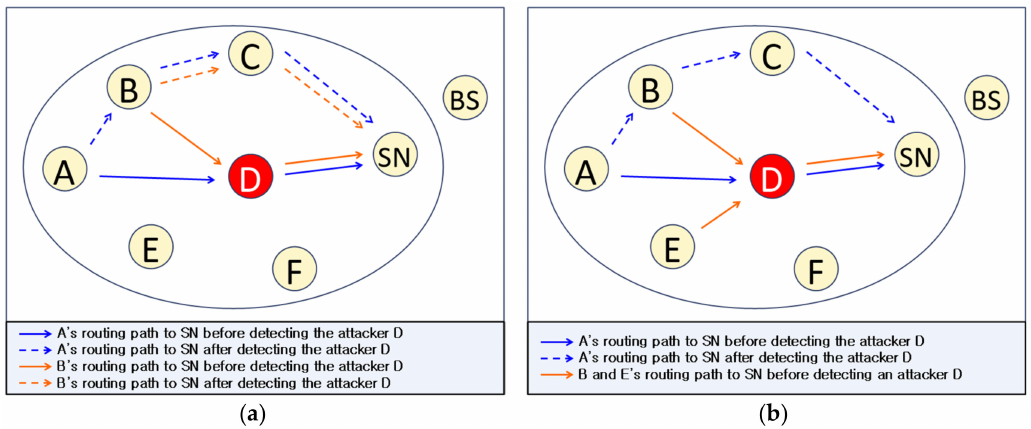
Figure 4. Motivational examples (two attack cases). ( a ) first attack case; ( b ) second attack